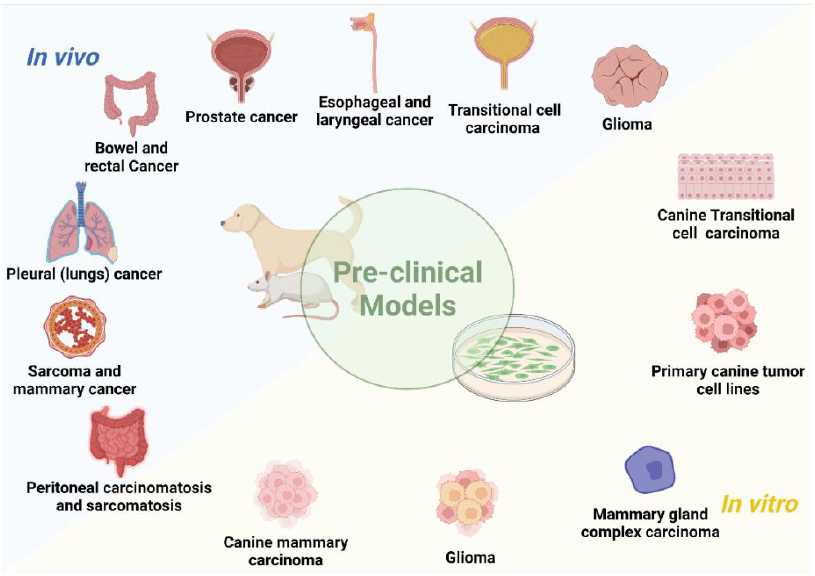
Figure 5. Preclinical applications of PDT in in vivo and in vitro models. Created with Biorender.com.